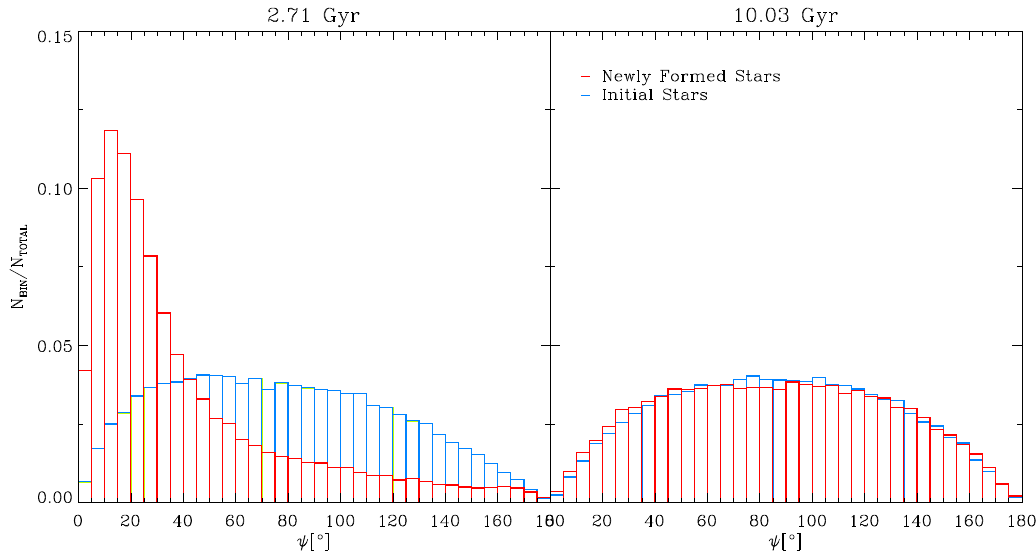
Figure 8. Distribution of the misalignment angles between the total stellar angular momentum vector of the KDC after and the angular momentum vectors of the individual stars inside the KDC. The newly formed stars are represented by the red histograms, while the blue histograms illustrate the initial stars. left : t = 2.71 Gyr; right : t = 10